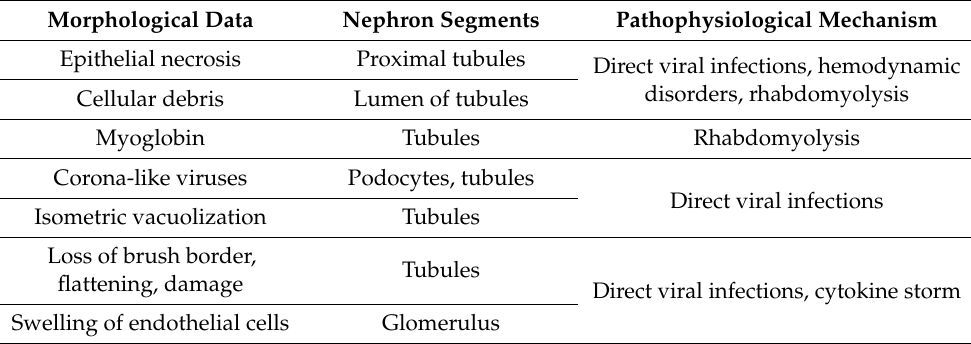
Table 2. The most common histopathological observations in COVID-19.